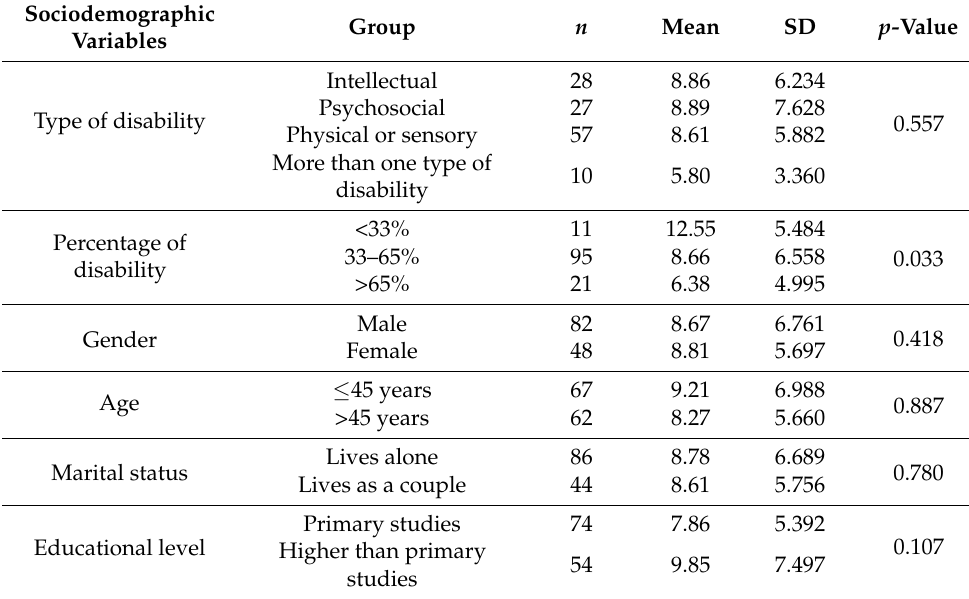
Table 3. Differences between groups in the primary outcome variable “cynicism” using ANOVA and Mann–Whitney U